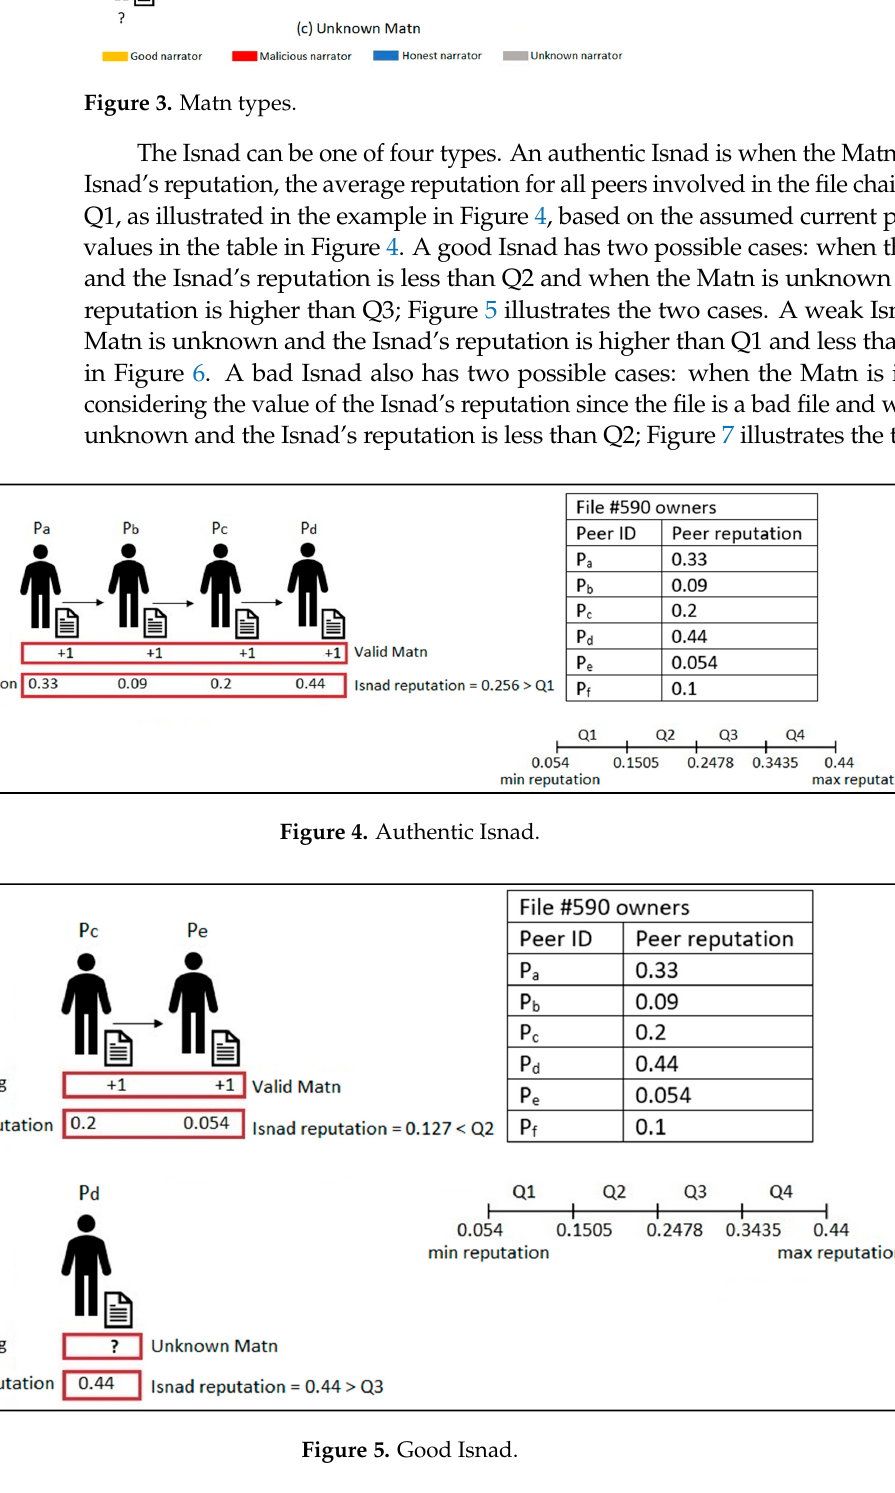
Figure 6. Weak Isnad. Figure 7. Bad Isnad.